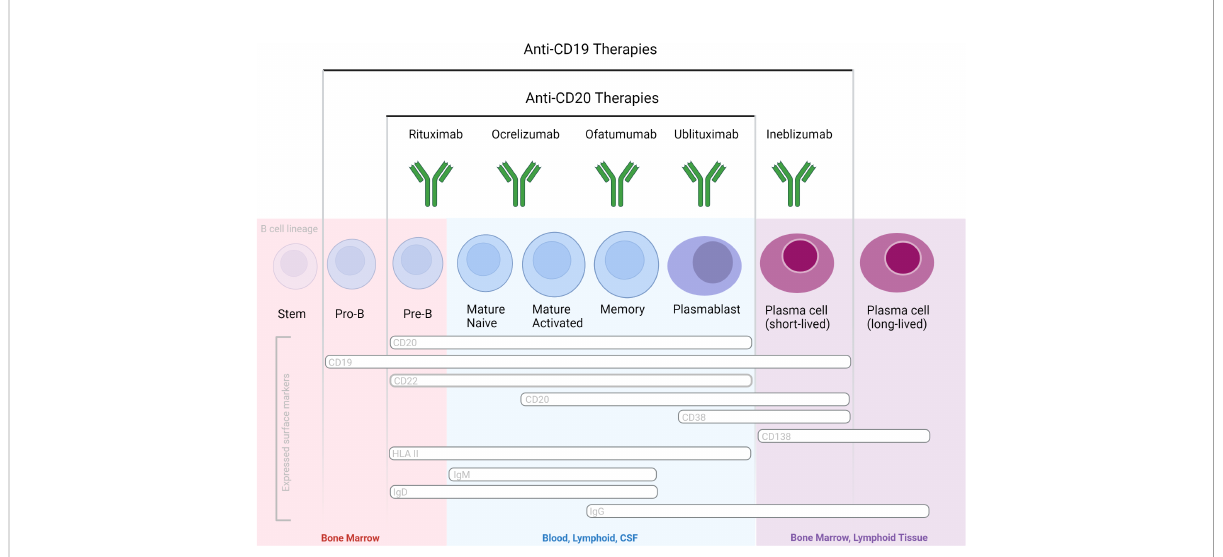
FIGURE 2 B cell-depleting mAbs with proven ef fi cacy in MS and NMOSD, based on phase 3 randomized controlled clinical trials. Therapeutic Abs differ in their molecular design and targeted